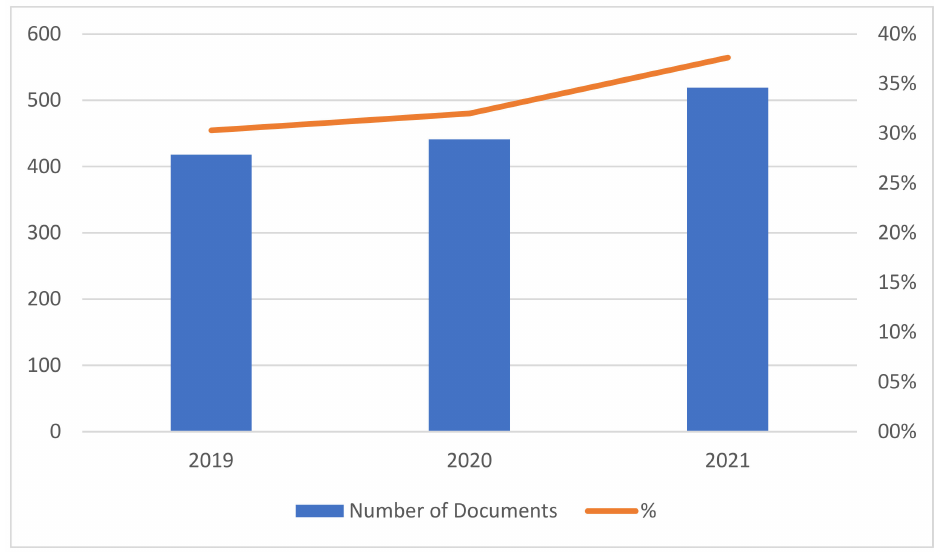
Figure 2. Renewable energy and agriculture publications for